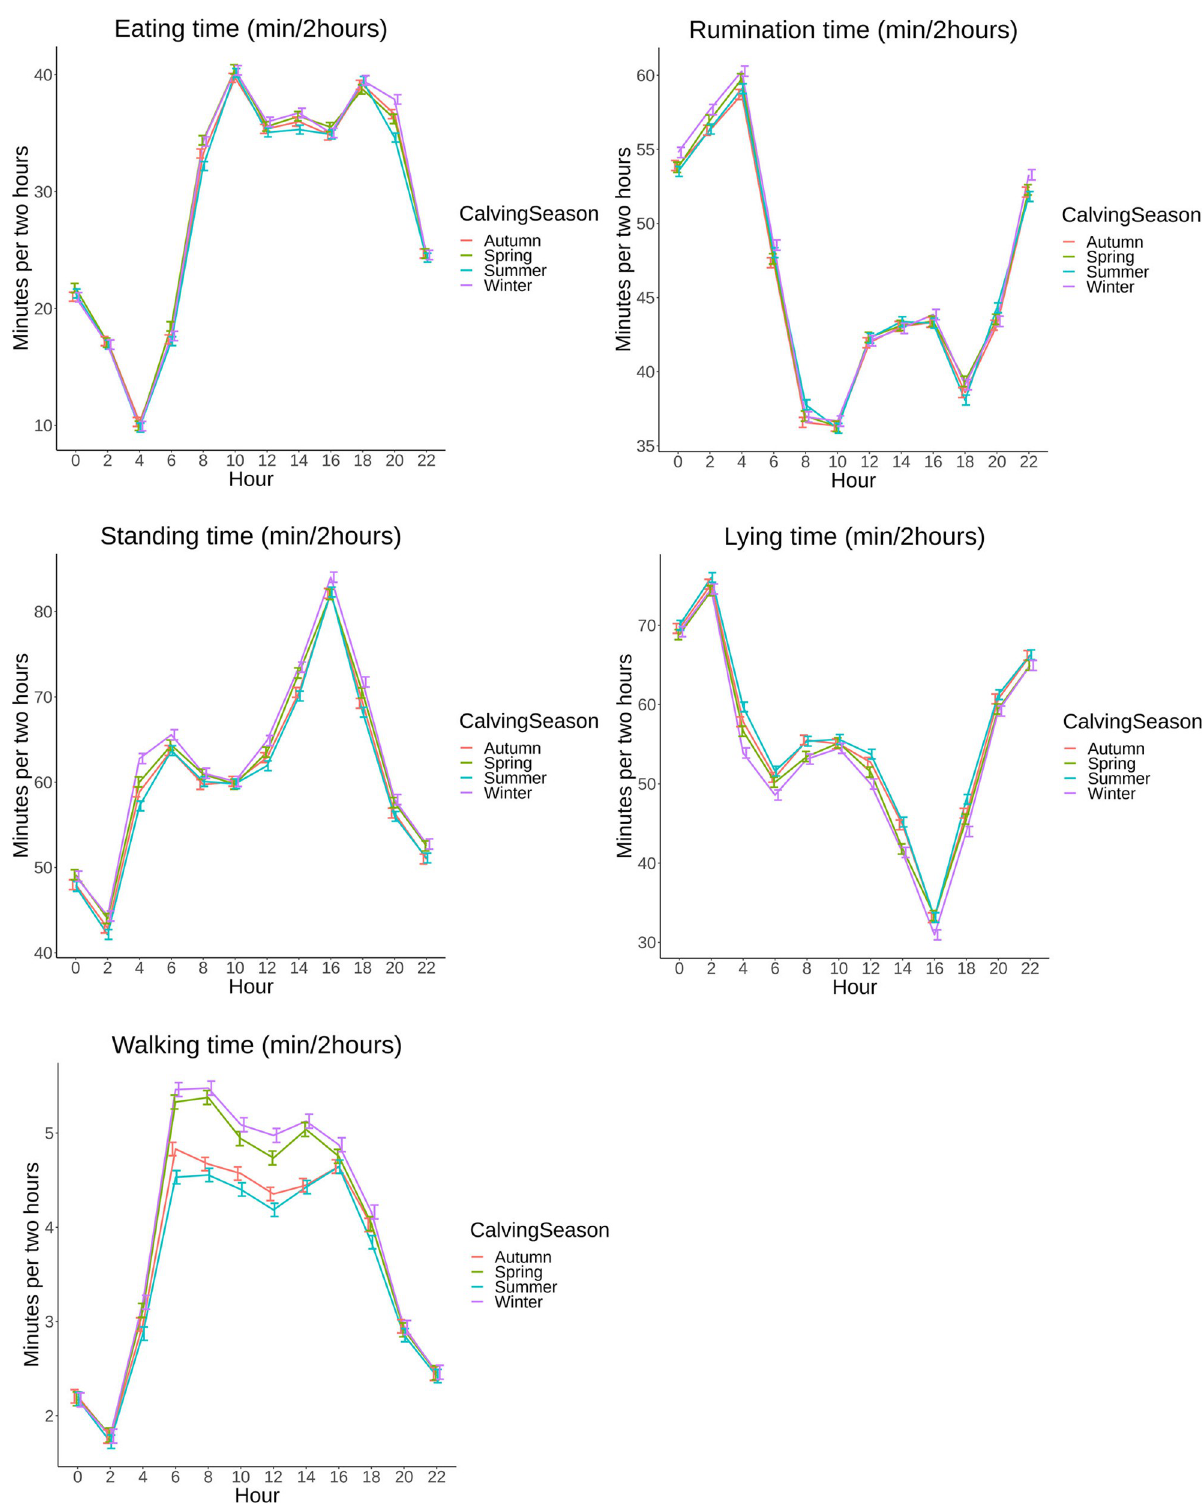
Fig 8. A,B,C,D,E: 24h pattern in minutes per 2 hours (min/2hours) based on least square means (LSM) with 95% confidence intervals (95% CI) grouped by calving season (Spring, Summer, Autumn, Winter) on 8 commercial dairy farms in The Netherlands from 00:00AM until 22:00PM.